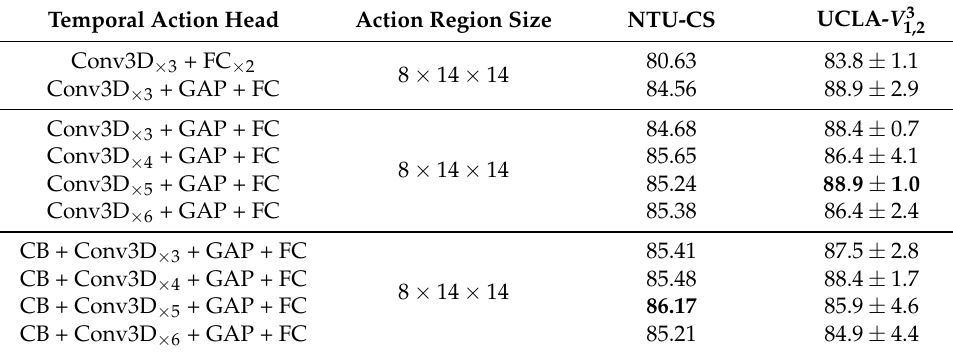
Table 5. Experimental results according to the addition of network elements. The output channel dimensions of FC in all the rows, Conv3D in the 2nd row and Conv3D in the 3rd row are 1024, 256 and 1024, respectively. The output channel dimensions of CB are 1024, 256 and 128 in